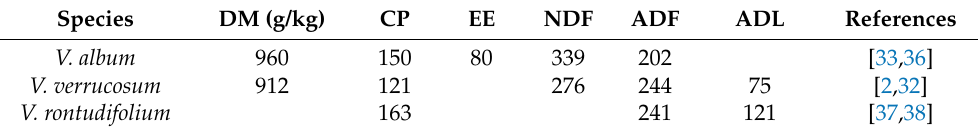
Table 2. Chemical composition (g/kg DM) of Viscum species. Species DM (g/kg) CP EE NDF